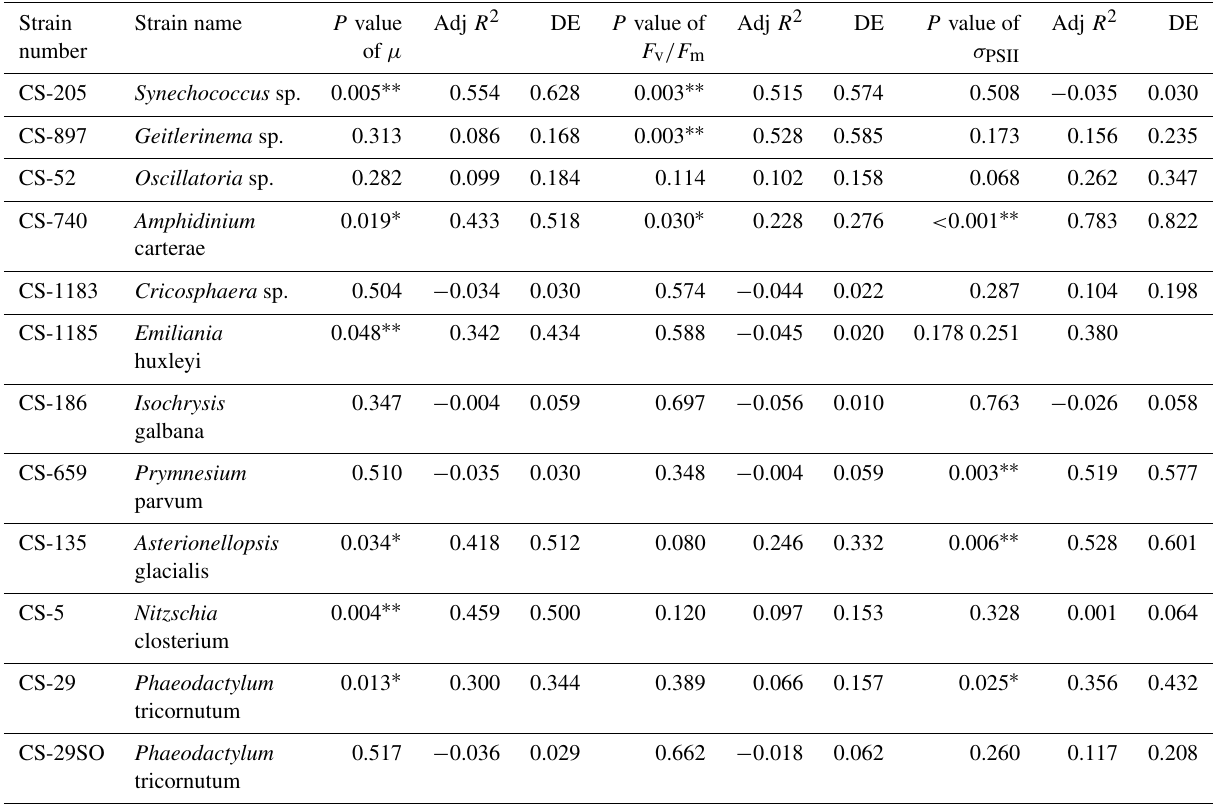
Table 2. Approximate significance of the smooth terms for GAMs. Three separate GAMs were used to calculate the impacts of p Ni on µ , F v /F m , and σ PSII (Eq. 2). P values < 0.05 indicate that the smooth term is significantly different from a straight line. P values < 0.05 are indicated by ∗ , and P values < 0.01 are indicated by ∗∗ . Adj R 2 is the adjusted R 2 value. DE stands for deviance explained.